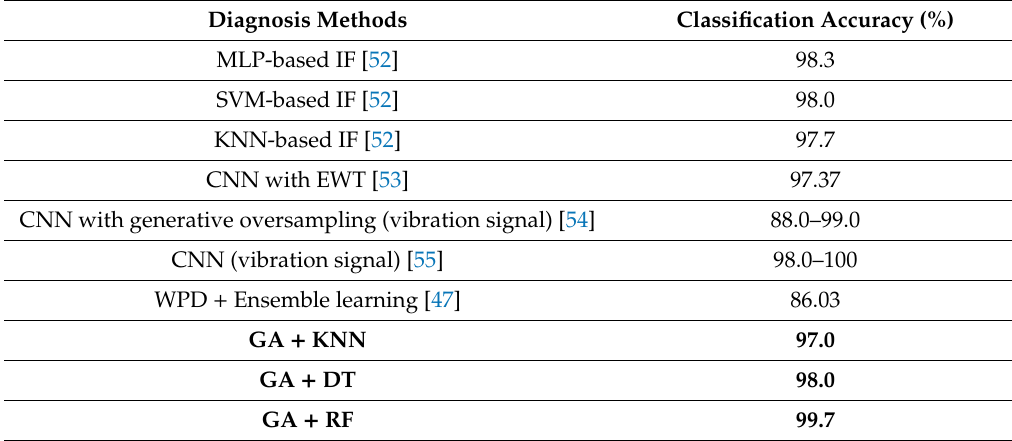
Table 8. Accuracy comparison among the di ff erent